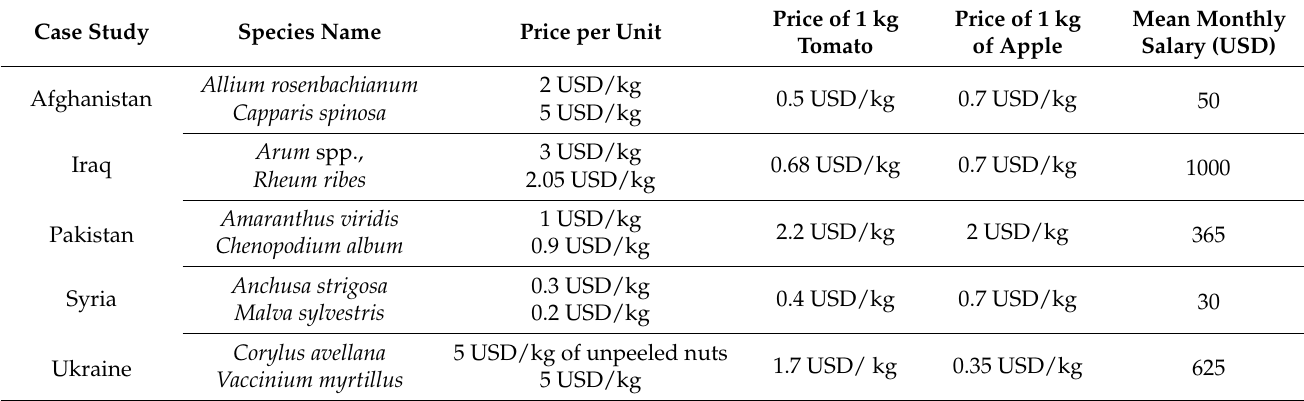
Table 3. Comparison of the prices of the most iconic wild food plants and of cultivated species in the five selected case